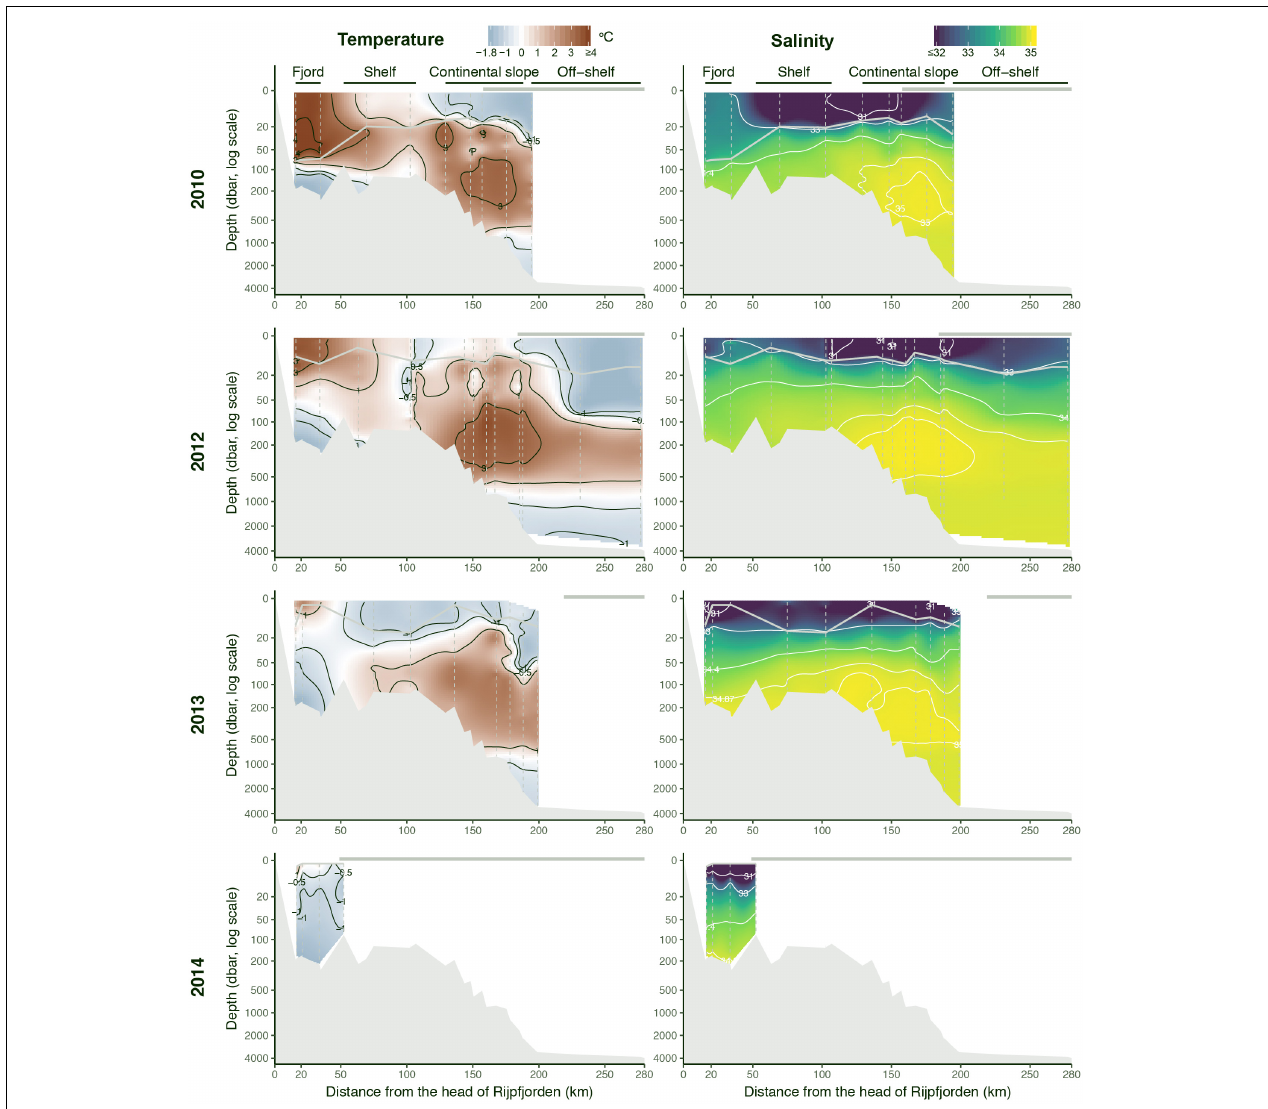
FIGURE 3 | Temperature and salinity along transects from inner Rijpfjorden to the deep Arctic Ocean, in July–August 2010, 2012, 2013, and 2014. Gray horizontal line at 0 m indicates the extent of consolidated pack ice, and they gray line on top of the gridded values is the depth of maximum stratification. The section from 2014 was limited to Rijpfjorden because of heavy sea ice. Vertical dashed lines indicate individual CTD